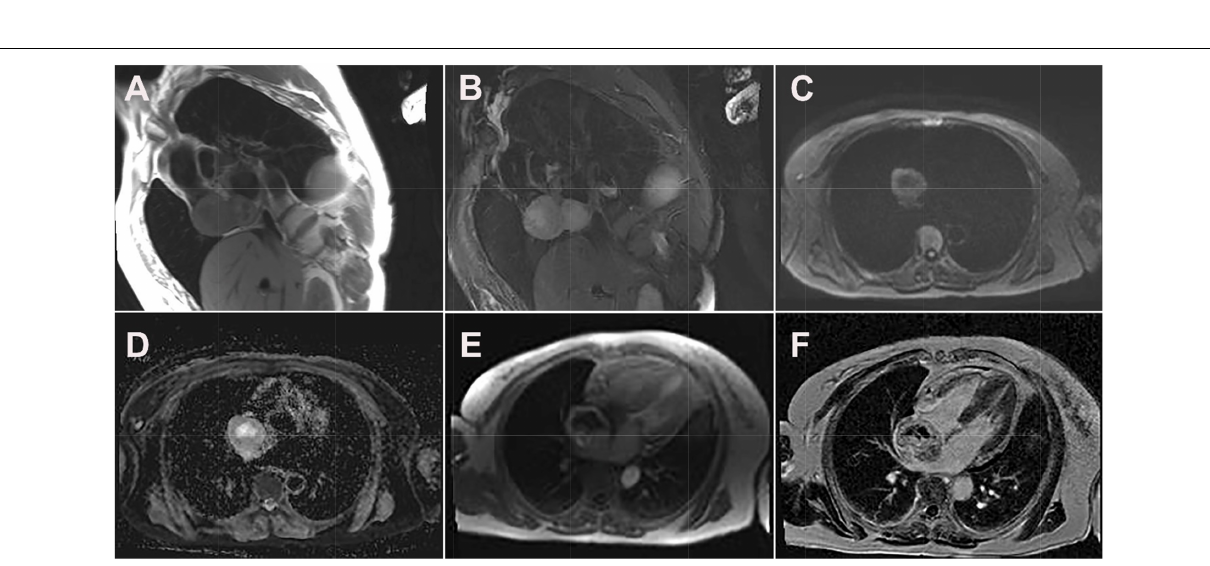
Frontiers in Medicine |